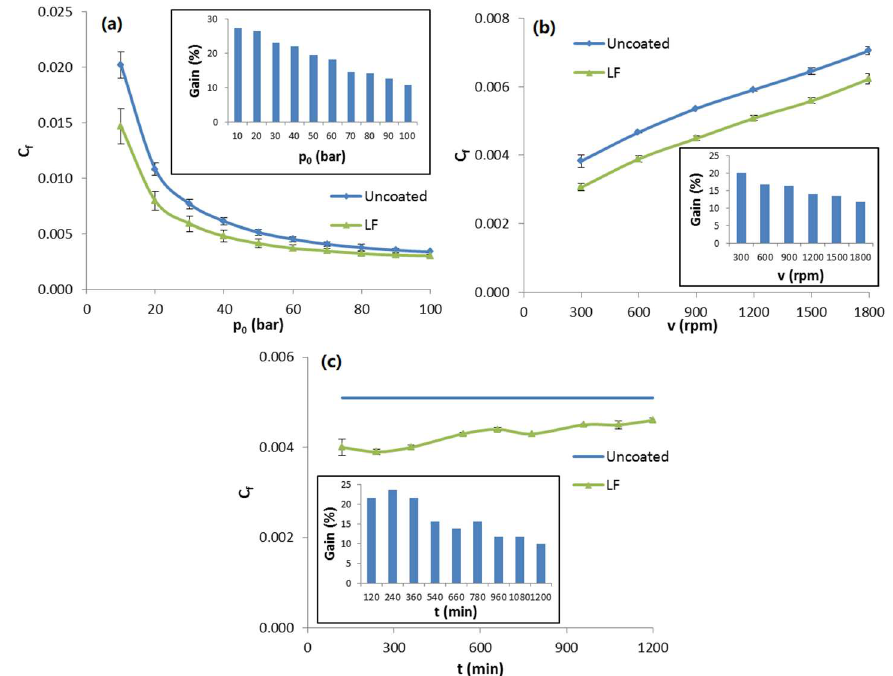
Figure 15. Friction coefficient C f measured during functional tests with variable pressure ( a ), variable rotational speed ( b ) and endurance tests ( c ) for LF slippers (green triangles) and uncoated ones (blue squares). Every inset reports the evolution of percentage gain in C f for LF samples compared to reference uncoated slippers.